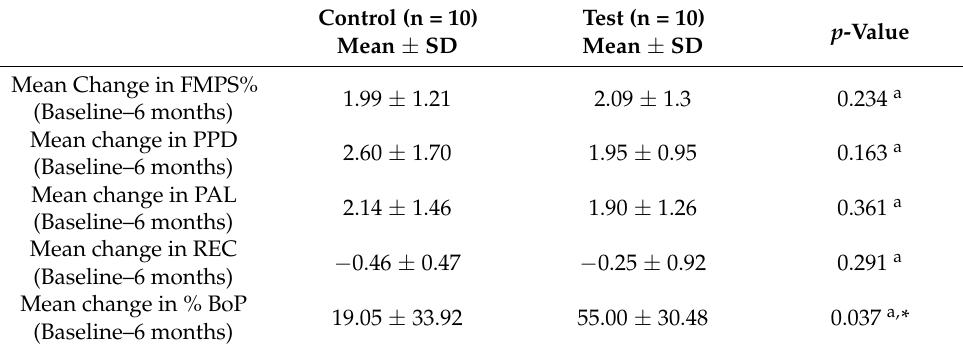
Table 3. Comparisons of the changes in clinical values between